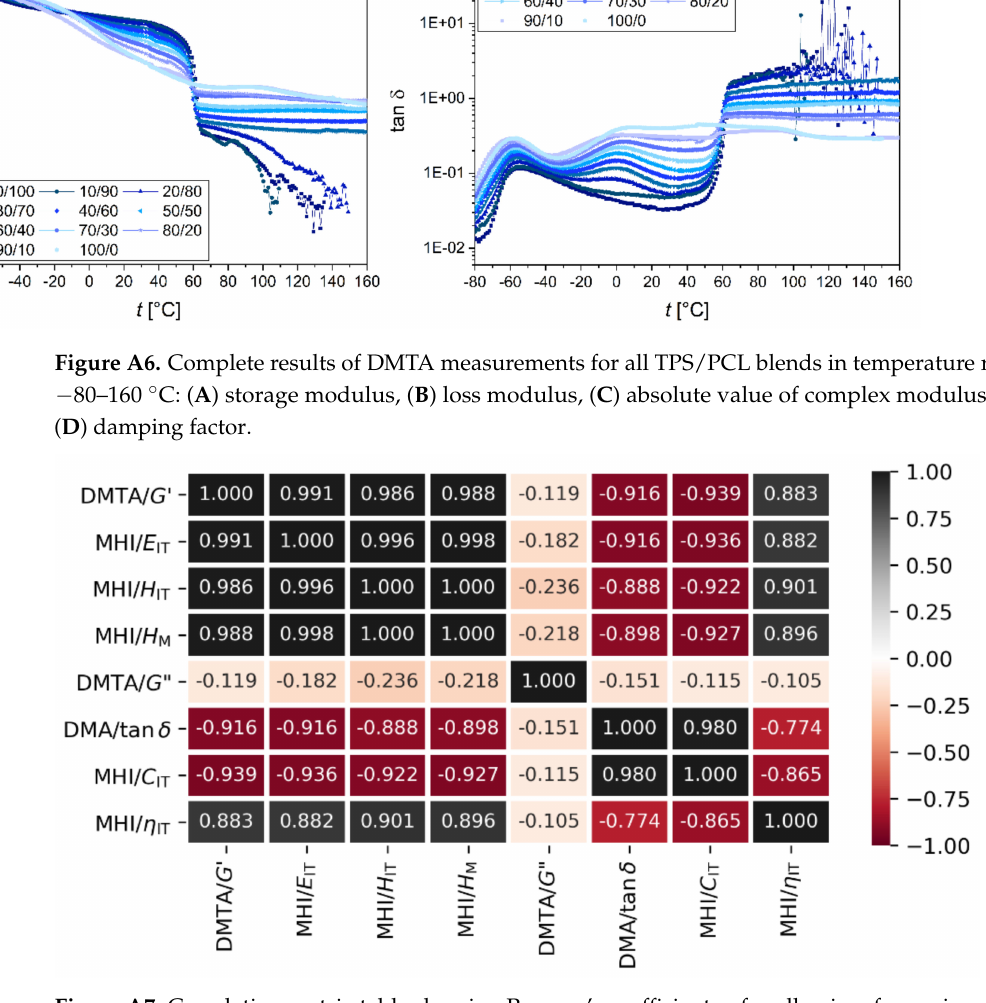
Figure A7. Correlation matrix table showing Pearson’s coefficients r for all pairs of experimentally determined properties in macro- and microscale. The table is presented as a heatmap (darker color means stronger correlation). The properties in the table are: storage modulus, loss modulus and damping factor from dynamic mechanical thermal analysis (DMTA/ G (cid:48) , DMTA/ G (cid:48)(cid:48) and DMA/tan( δ )) and elastic modulus, indentation hardness, Martens hardness, indentation creep, and elastic part of indentation work from MHI measurements (MHI/ E IT , MHI/ H IT , MHI/ H M , MHI/ C IT and MHI/ η IT ). We note that the correlation matrix is symmetric with respect to the main diagonal, which contains values equal to 1